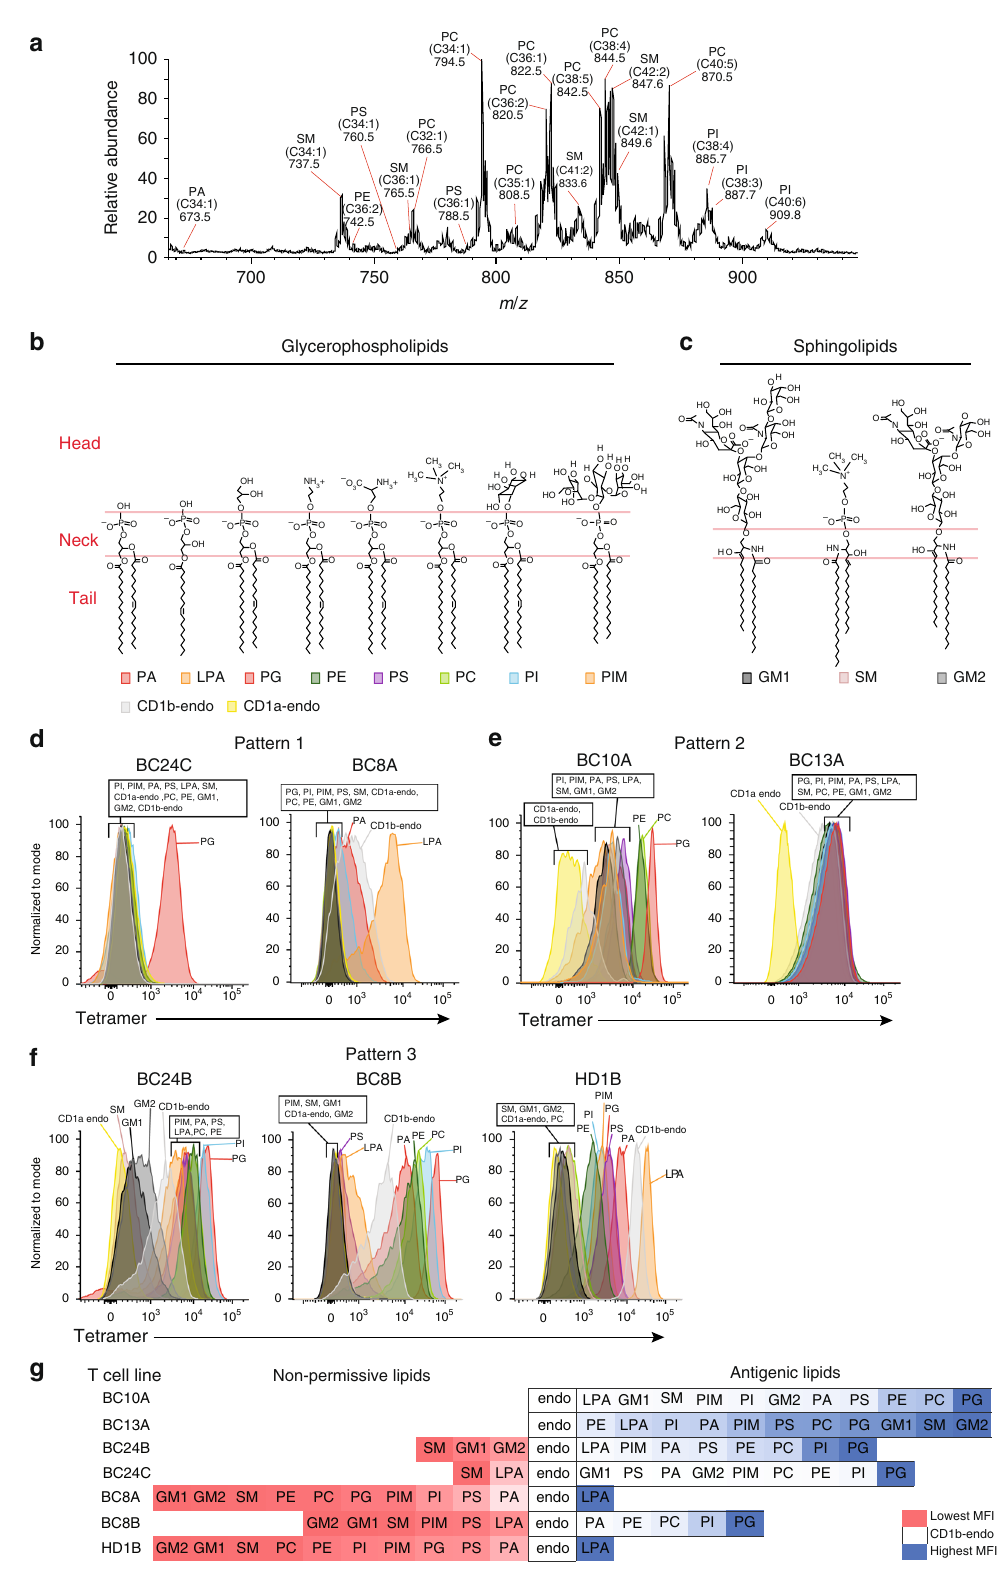
(nanoESI) ion trapping MS, identifying ions corresponding to deprotonated ions of phosphatidic acid (PA, m / z 673.5), phos- phatidylethanolamine (PE, m / z 742.5), phosphatidylserine (PS, m / z 760.5), and phosphaditylinositol (PI, m / z 885.7, 887.7, 909.8). Further we detected chloride adducts of phosphatidylcholine (PC,